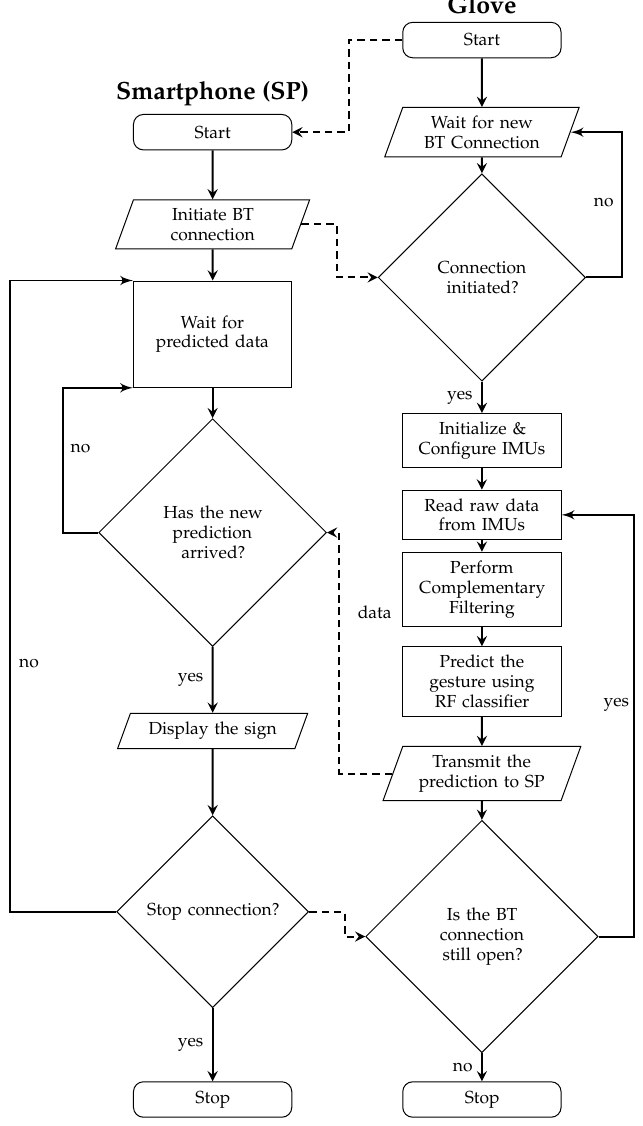
Figure 9. The flowchart describing the entire setup and communication process between smartphone and our glove prototype (BT—Bluetooth, IMU—Inertial Measurement Unit, RF—Random Forest